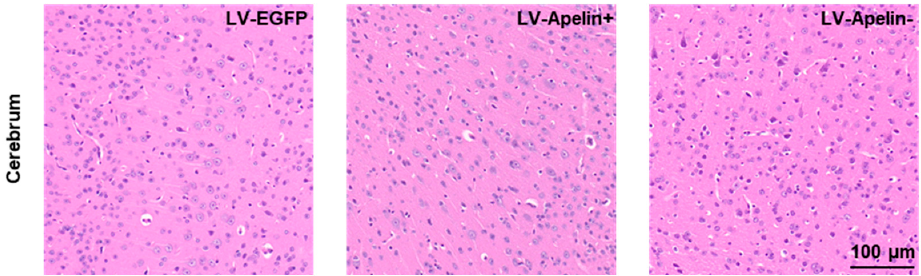
Figure 6 . Effects on the cerebrum in DR mice treated with LV-EGFP, LV-Apelin+, or LV-Apelin − . Representative HE staining images revealed that the intravitreal injection of the LV had no obvious side effects on the